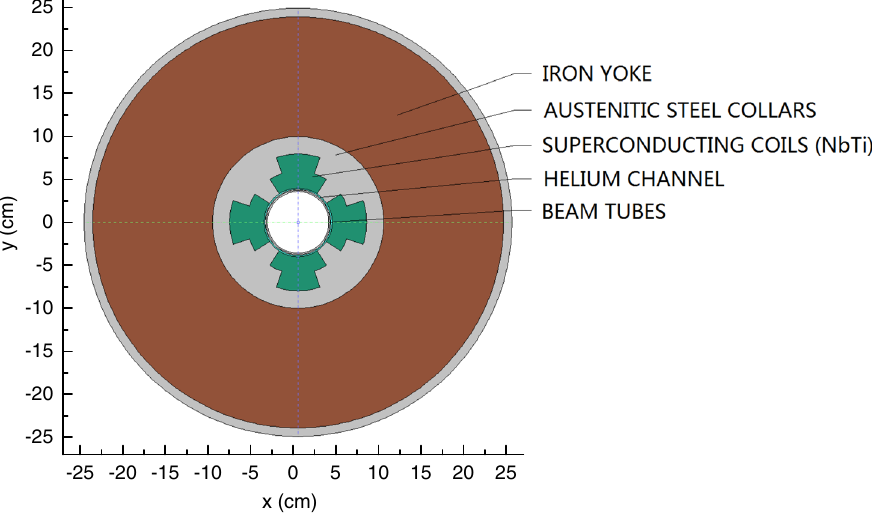
FIG. 13. Cross section of the SC quadrupole in the transverse collimation